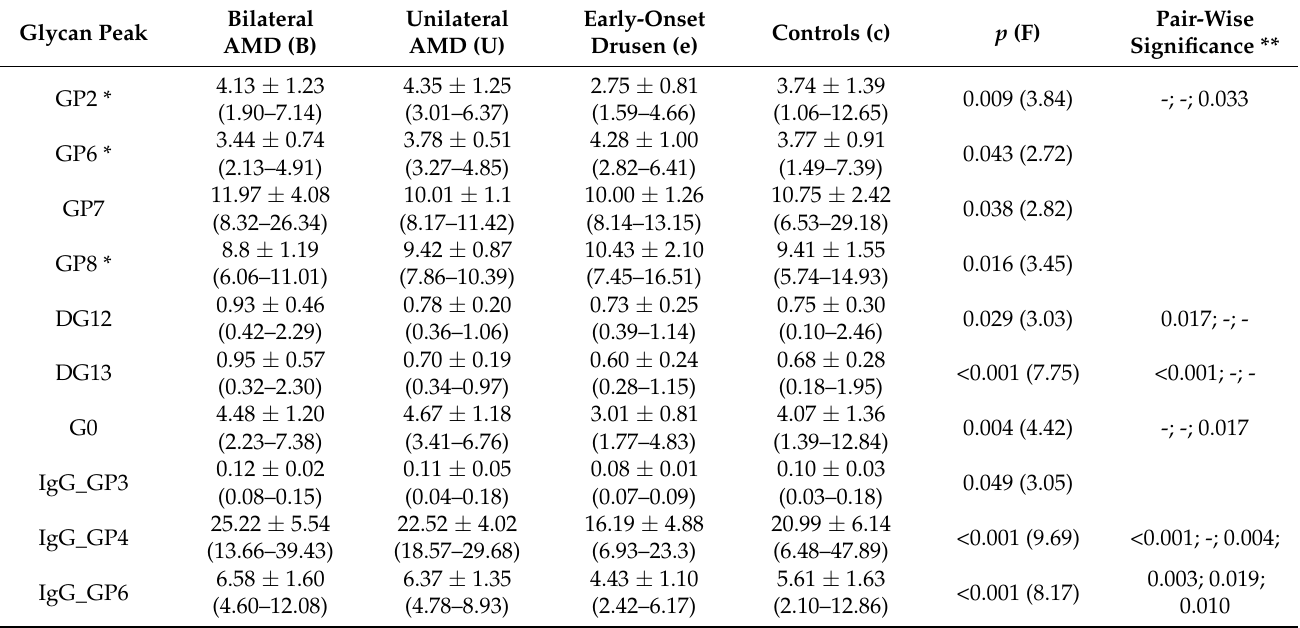
Table 2. The selection of N -glycans that had significant differences from the control group across the disease stages and controls (the entire set is provided in Supplementary Table